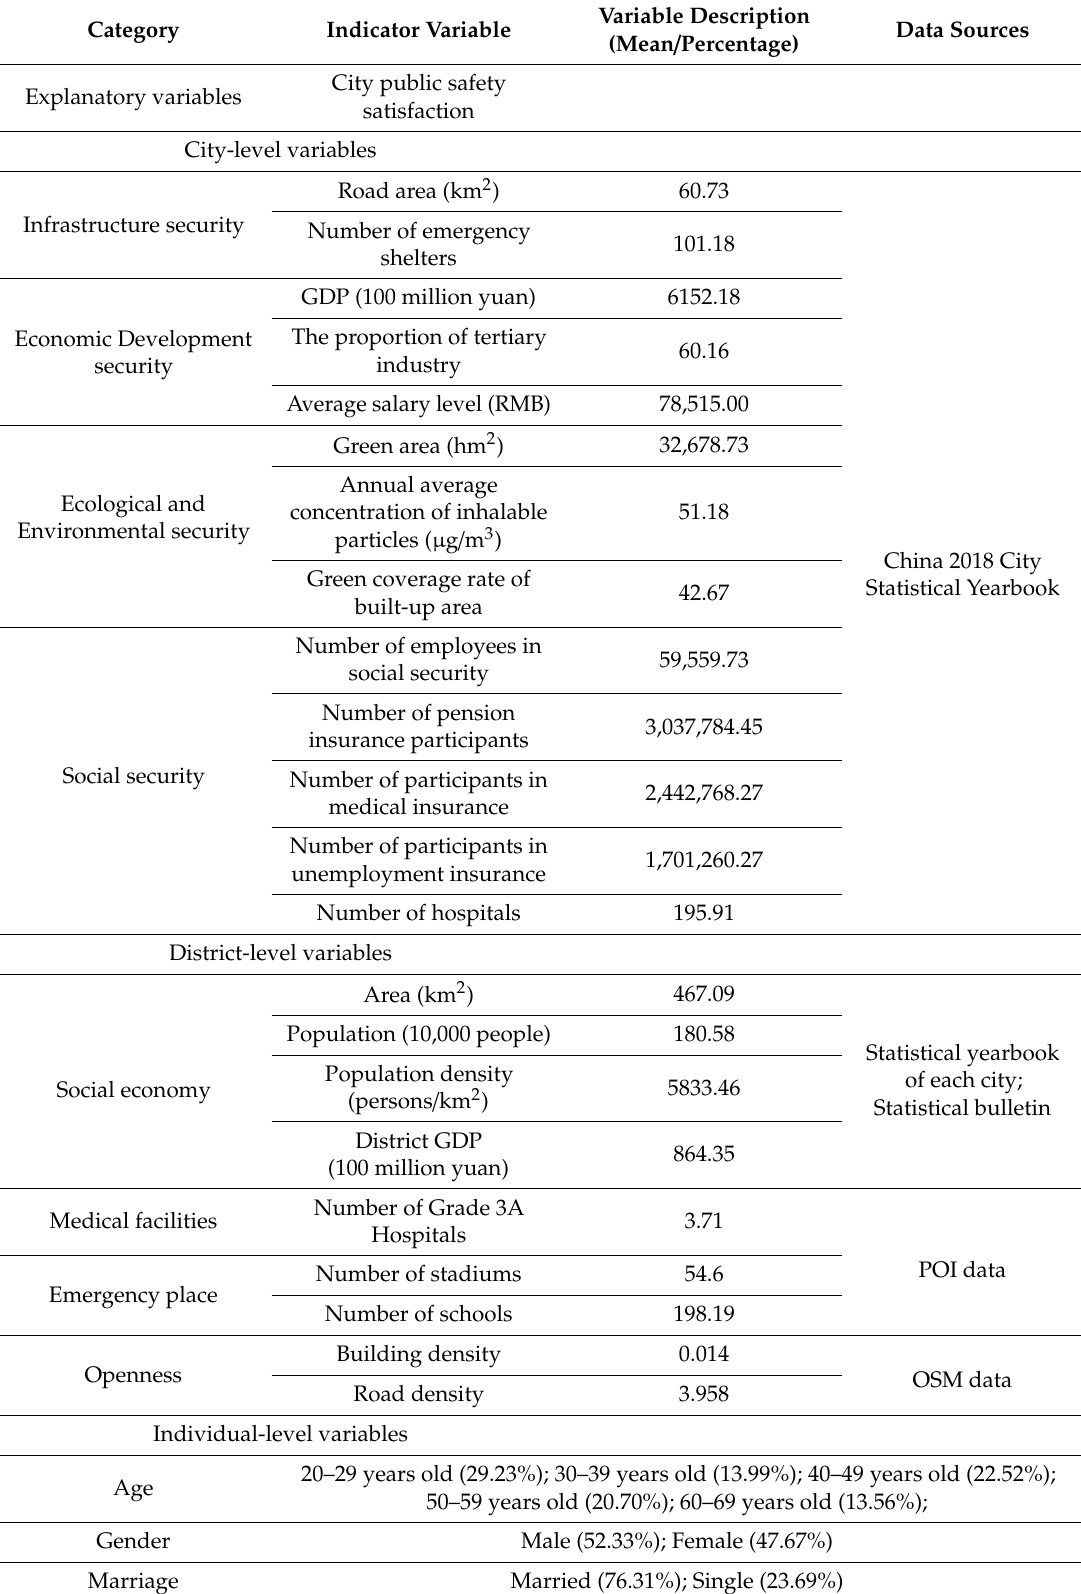
Table 1. Description and statistics of selected